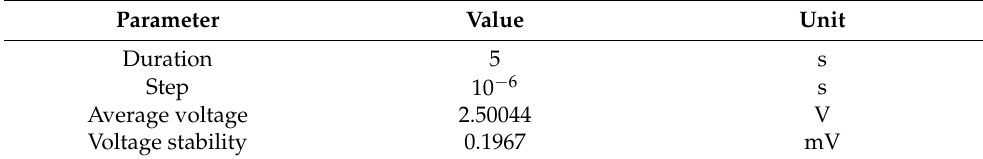
Figure 18. Noise spectrum of z-axis. Table 6. Simulation results of